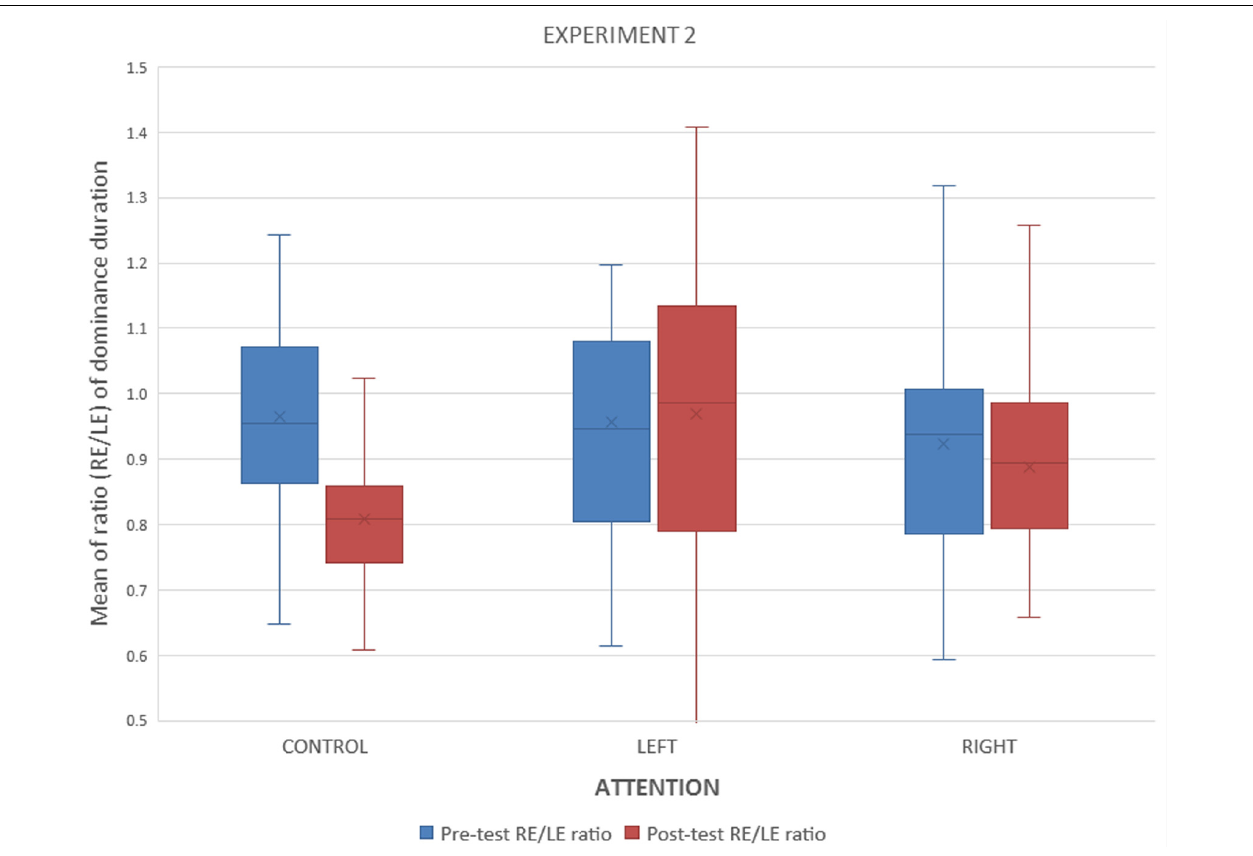
FIGURE 6 | Experiment 2. Interocular ratios (right/left) of dominance durations before and after the monocular counting task for each group on the counting task.